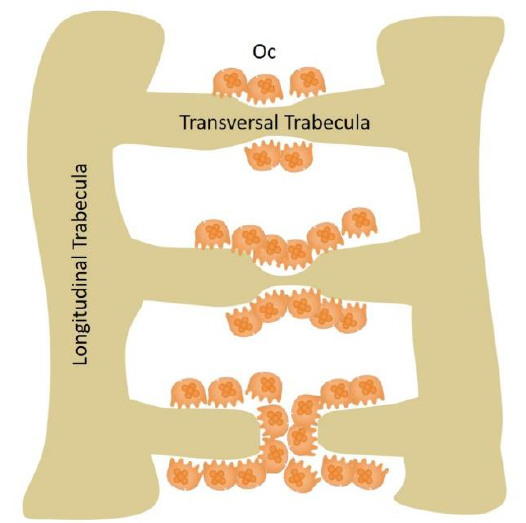
Figure 2. Schematic illustration of the resorption and subsequent perforation of a trabecula by osteoclasts.